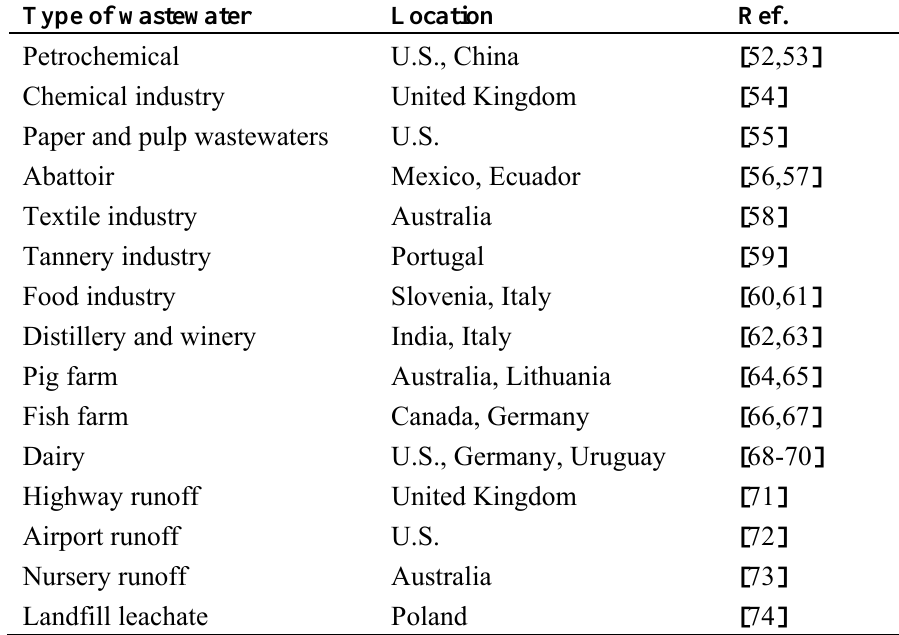
Table 3. Examples of the use of HF CWs for various types of